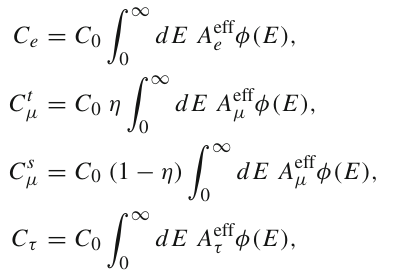
Fig. 2 On the left panel: the baseline single flavor spectrum of astro- physical neutrinos is represented with a solid green curve. It is obtained following the shape and the normalization suggested by throughgoing muons above 200 TeV [11] and shape suggested by HESE below 200 TeV [25]. The green band is related to the uncertainty on the measured